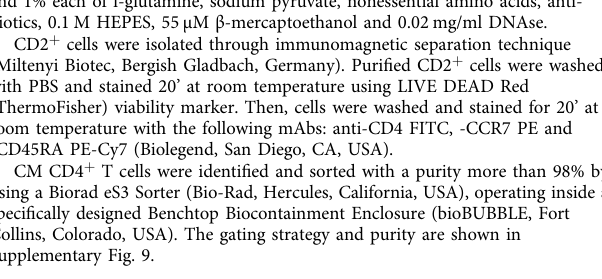
Fig. 6 Monocytes reclustering in CUN and COV patients. a UMAP plot shows the 2D spatial distribution of 1,608,200 cells from healthy subjects (HD, n = 10), CUN ( n = 7) and COV ( n = 10) embedded with FlowSOM clusters. b Monocytes heatmap shows the median marker intensities of the 14 lineage markers across the 8 cell populations obtained with FlowSOM after the manual metaclusters merging. Lightgrey bar along the rows (clusters) and values in brackets indicate the relative sizes of clusters. CL classical monocytes, INT intermediate monocytes, NC non-classical monocytes. c Dotplots show the relative cells percentage of the 8 clusters among healthy donors (HD; salmon circles; n = 10), CUN (green squares; n = 7) and COV (azure triangles; n = 10). The central bar represents the mean ± SEM. GLMM test was used for the statistical analysis. Exact p -values are reported in the fi gure. d Dotplots show the surface median expression (number of molecules) of the HLA-DR and PD-L1 on total monocytes among CUN and COV patients. Total monocytes were selected from CyTOF unsupervised analysis (Fig.2). The central bar represents the mean ± SEM. Kruskal-Wallis test with Benjamini-Hochberg correction for multiple comparisons was used to test the differences among the three groups; p -values are indicated in the fi gure. e Spearman correlation between plasmatic IL-6 and PD-L1 median expression on total monocytes in both CUN and COV patients (left); Spearman correlation between the plasmatic IL-6 and median expression of the HLA-DR on total monocytes in both CUN and COV patients